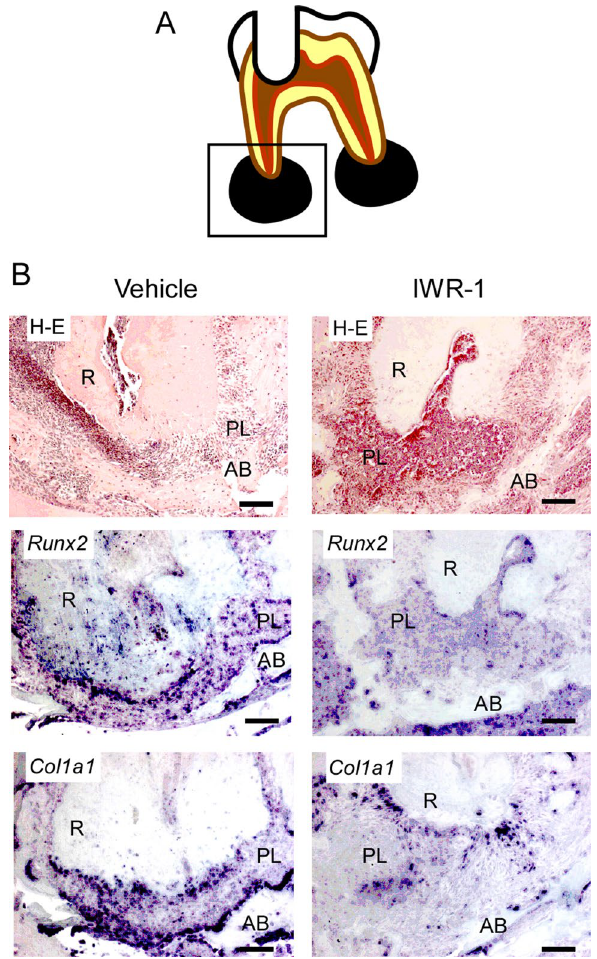
Figure 3. Inhibition of the Wnt/β-catenin signaling pathway resulted in suppressed expression levels of osteoblast differentiation markers. Periapical lesion tissues within a rectangular frame ( A ) of the vehicle group and the IWR-1 group were subjected to H–E staining and in situ hybridization for Runx2 and Col1a1 ( B ). R root, PL periapical lesion, AB alveolar bone. Scale bars = 100